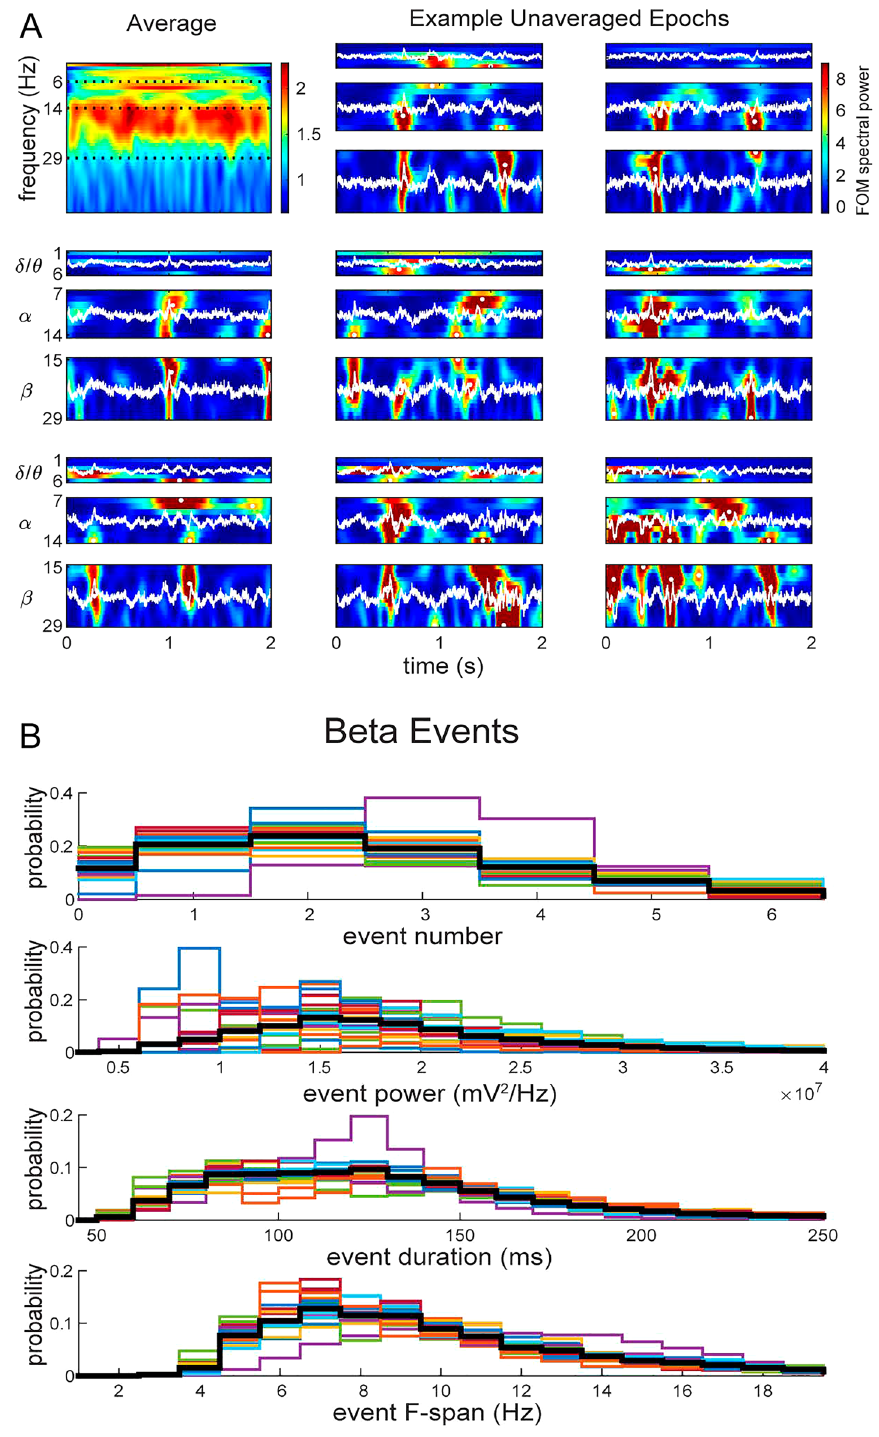
Figure 4. Low-frequency rhythms emerge as quantifiable transient high-power events (white dots) from non-averaged time-series waveform (white line) converted into TFRs. ( A ) Spectrogram showing average Fpz electrode power (normalized by the median value of each frequency) over frequency and time across all pre-treatment epochs from an example patient (top left), and time–frequency spectrograms of eight randomly chosen individual epochs for each BOI. Color bar denotes heat map of power values as factors of the median (FOM) spectral power. ( B ) Histograms showing the distribution of all beta event feature measurements from the Fpz electrode for individual patients (colored lines) and the average (black line). Event number is counted over 2 s epochs. See Supplementary Info for further Spectral Event feature quantification across frequency bands (Fig. S.2) and across all electrodes (Table